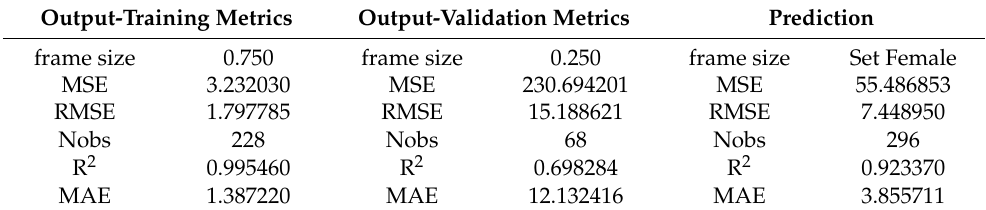
Table 3. Parameters of the generated model—age assessment for women.